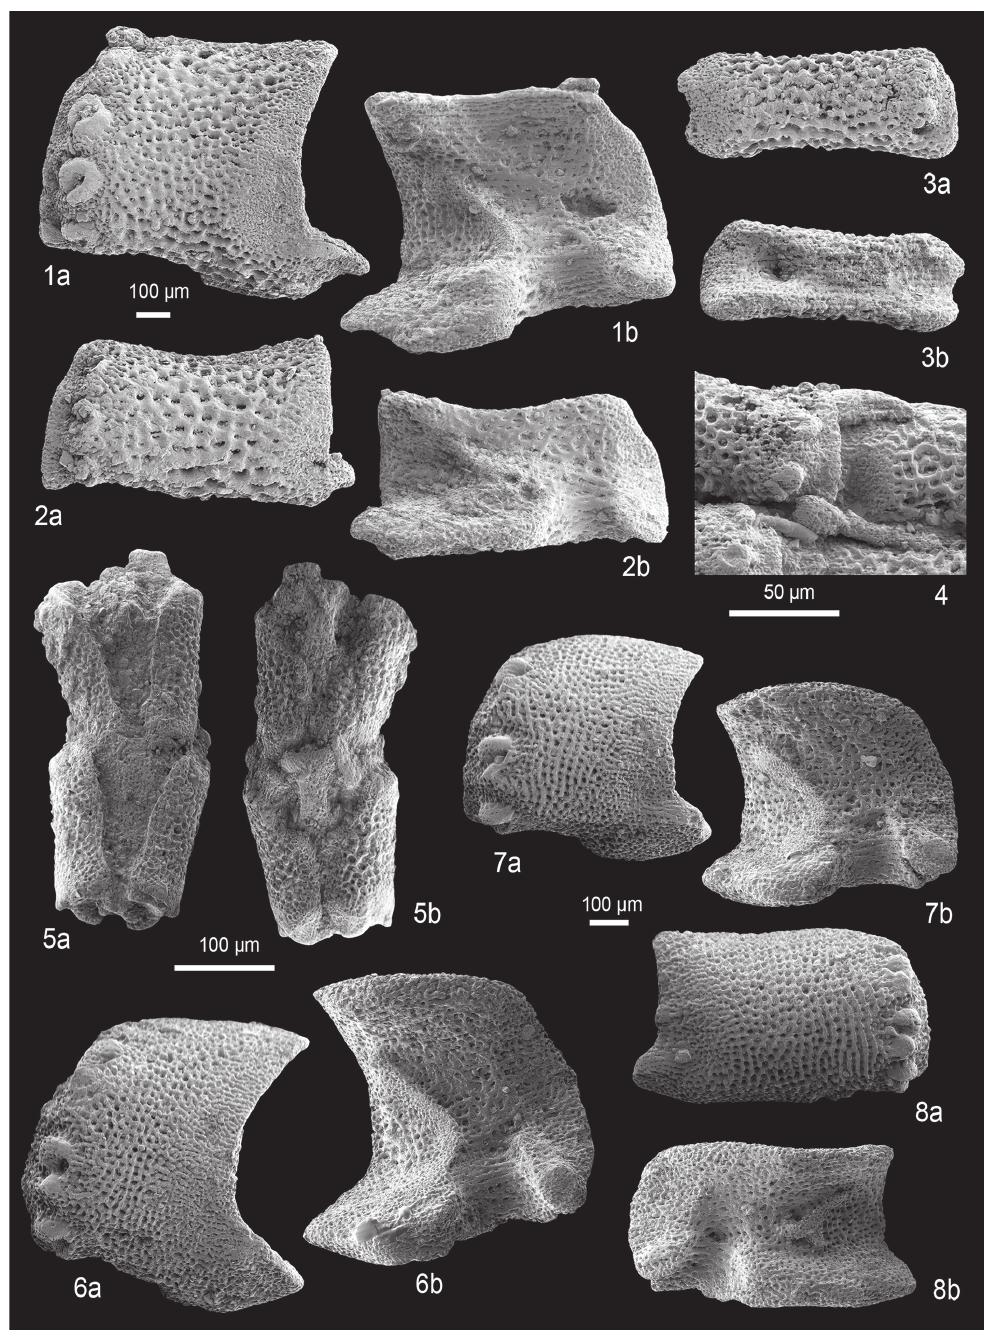
Fig. 9. Fossil lateral arm plates (LAPs) of ophiacanthid brittle stars in external (a) and internal (b) views and articulated arm fragments. 1-5. Lapidaster etteri gen. et sp. nov. from the early Oxfordian (Late Jurassic) of Longecombe, France. 1. NHMB M11209 (holotype), proximal LAP. 2. NHMB 11210 (paratype), median LAP. 3. NHMB M11211 (paratype), distal LAP. 4. NHMB M11212 (paratype), distal arm fragment in lateral view. 5. NHMB M11213 (paratype), distal arm fragment in dorsal (a) and ventral (b) views. 6-8. Lapidaster mastodon gen. et sp. nov. from the late Oxfordian (Late Jurassic) of the Plettenberg, Germany. 6. GZG.INV.78517 (holotype), proximal LAP. 7. GZG.INV.78518 (paratype), median LAP. 8. GZG.INV.78519 (paratype), distal LAP. One common scale bar per species is given, except for 4 and